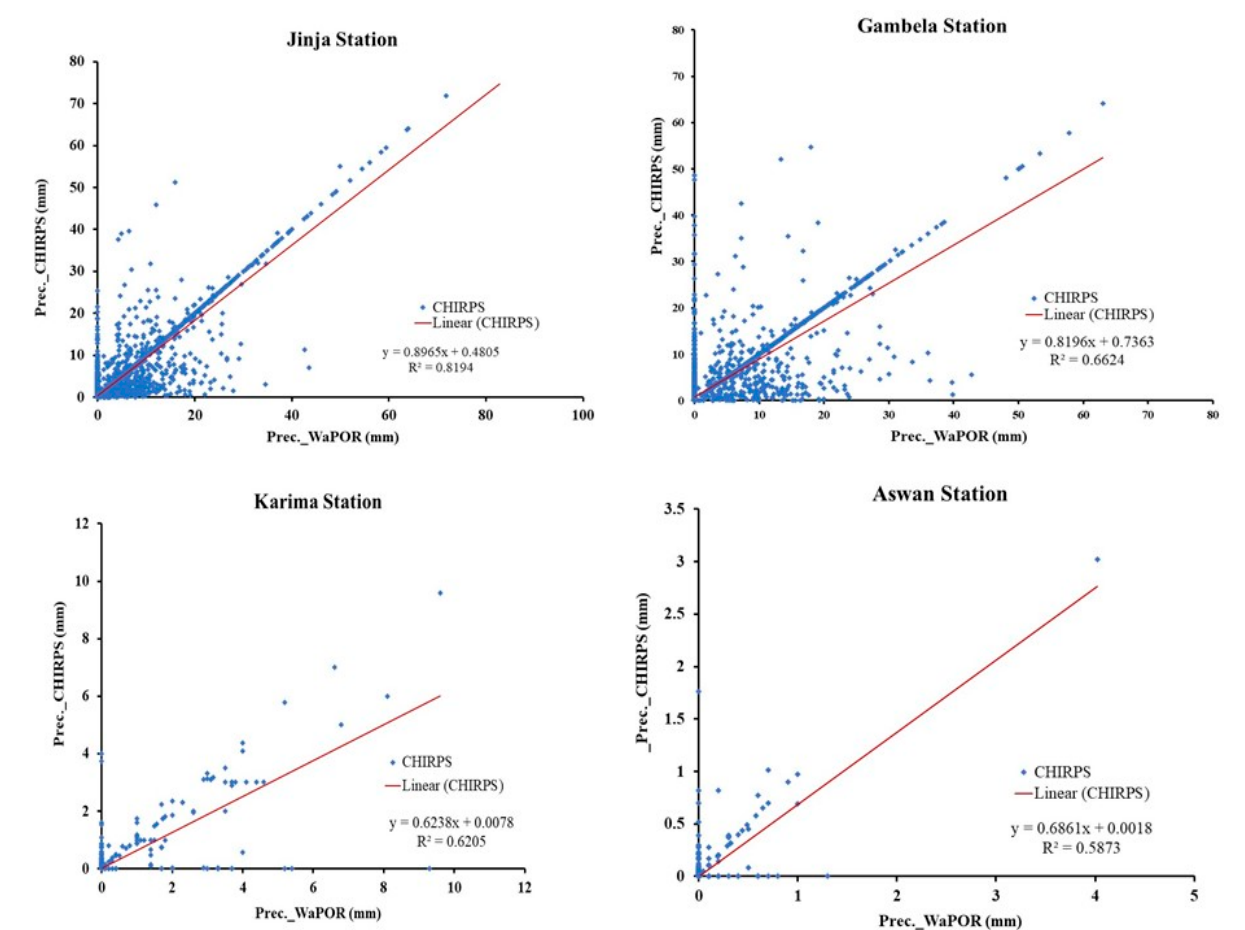
Figure 4. Comparison between the daily precipitation (collected from CHIRPS dataset) and precipitation (collected from WaPOR) at Jinja, Gambela, Karima, and Aswan meteorological stations from 2009 to 2020. The red line indicates the linear fit between values.